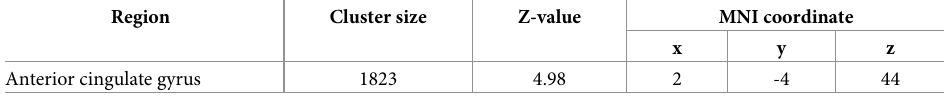
Table 2. Identified region showing significant group difference and the corresponding anatomical area.